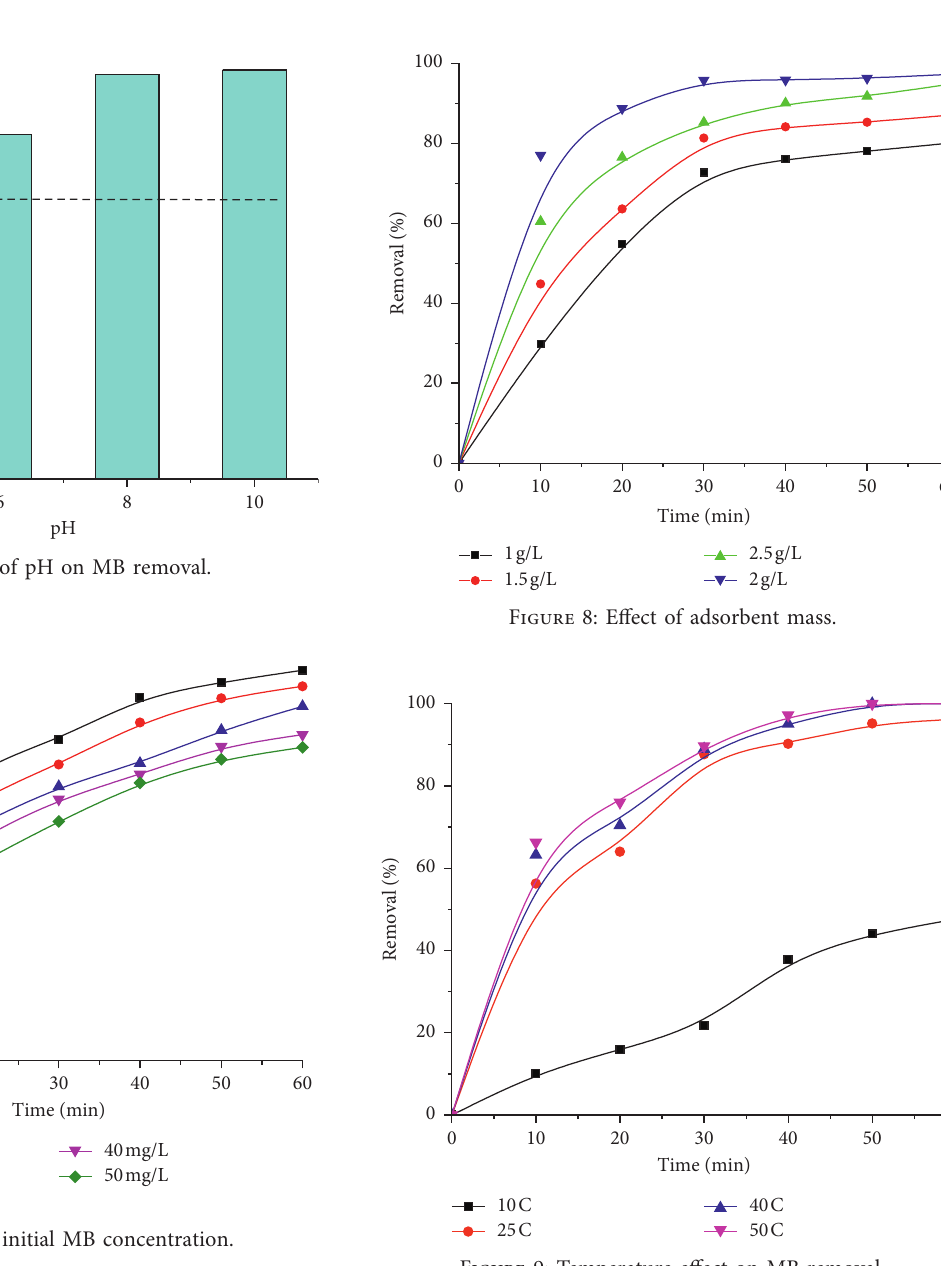
Figure 9: Temperature effect on MB